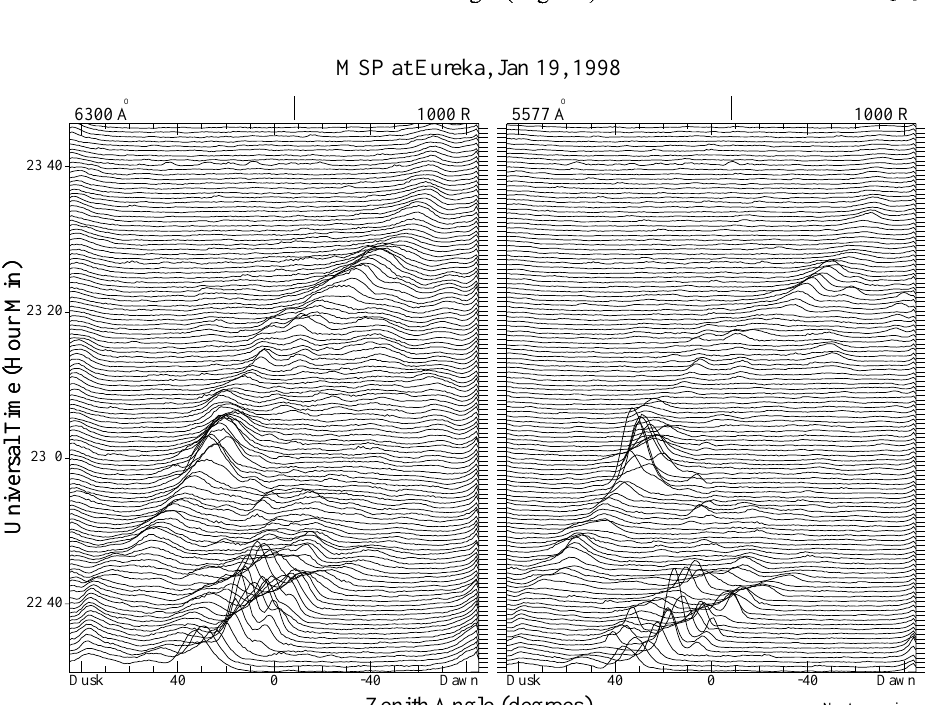
Fig. 13. Plots of MSP scans from 1530 to 1630 UT on Janu- ary 19, 1998. Vertical bars at the top denote 3000 R